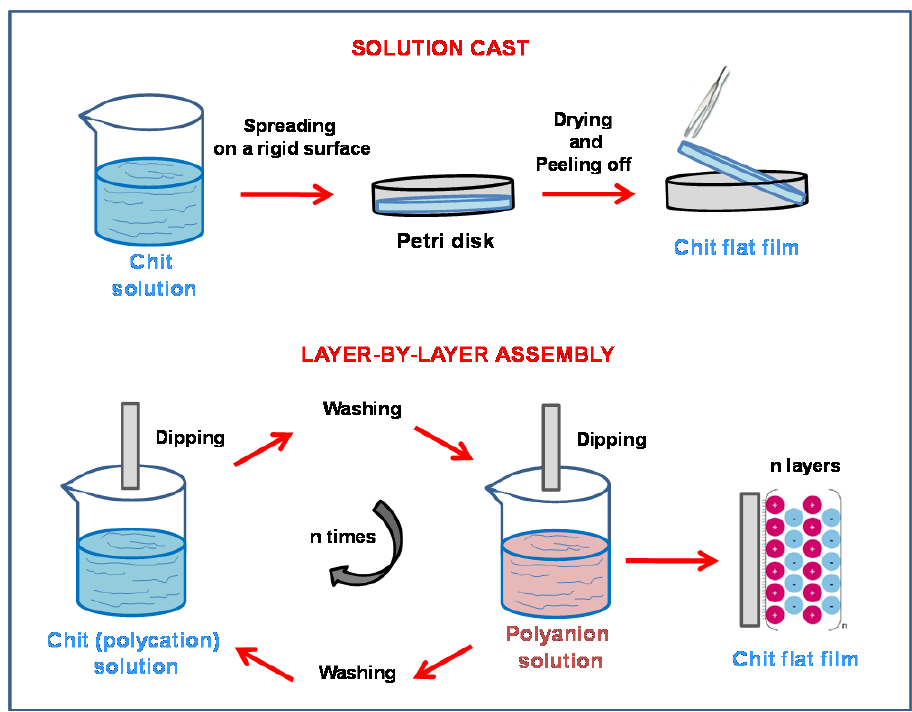
Figure 3. Scheme of solution-cast and LBL assembly methods for the fabrication of chitosan-based flat structures starting from a chitosan polycation solution (low pH, Chit-soluble form).